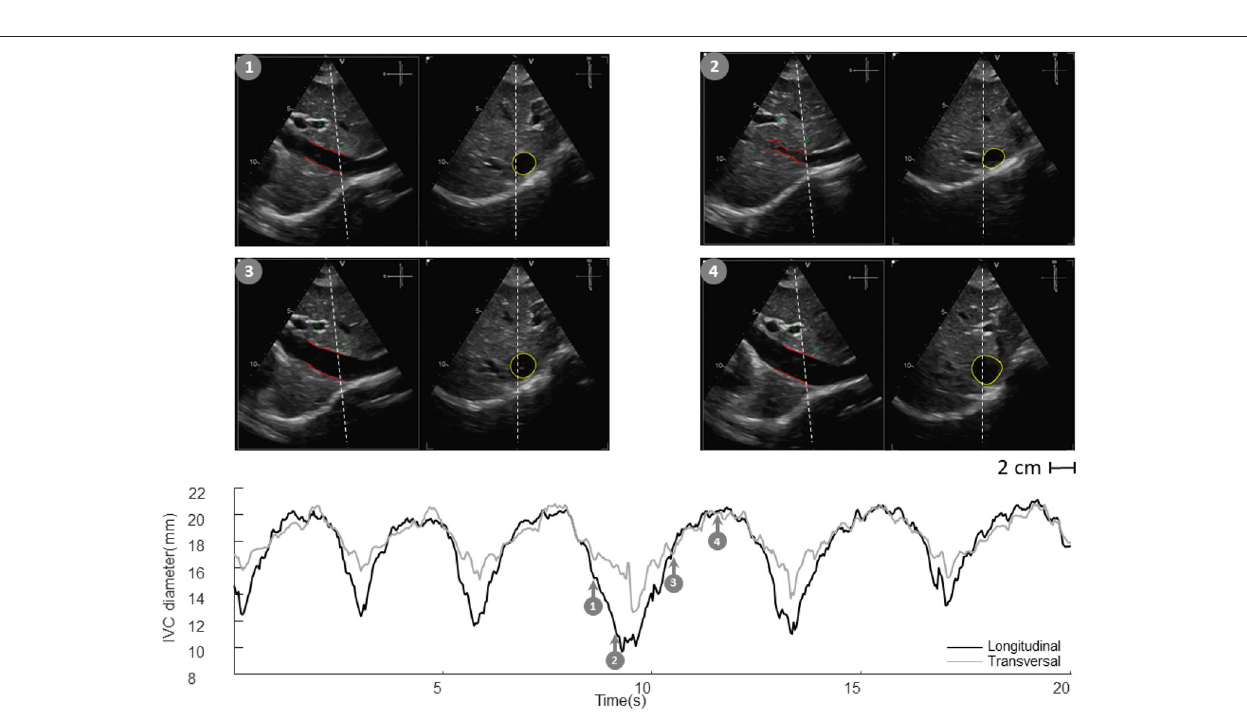
FIGURE 4 | Inferior vena cava (IVC) echography in x-plane. Both long and short axis views are available in synchronous scans. The sections can be displaced with respect to the center of the vessel. Moreover, they could be not orthogonal to the IVC axis. The estimation of the diameter in a single section can be largely